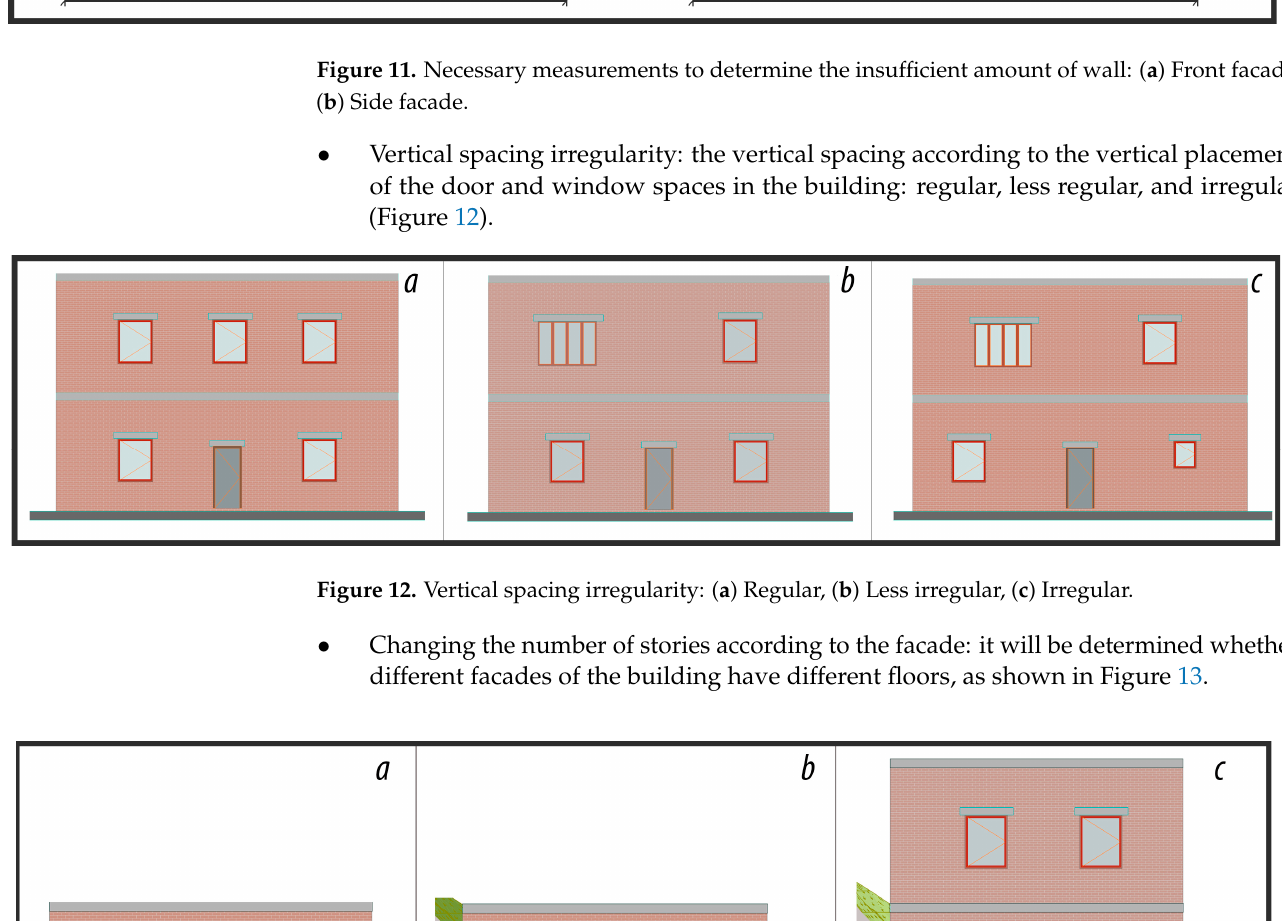
Figure 12. Vertical spacing irregularity: ( a ) Regular, ( b ) Less irregular, ( c ) Irregular.